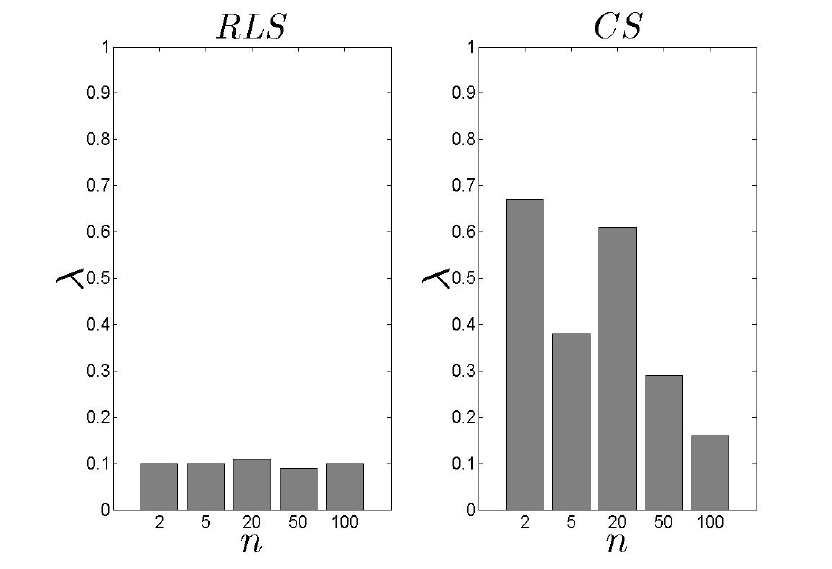
Figure 13. RLS and CS results for the λ metric ( |F| = 10).